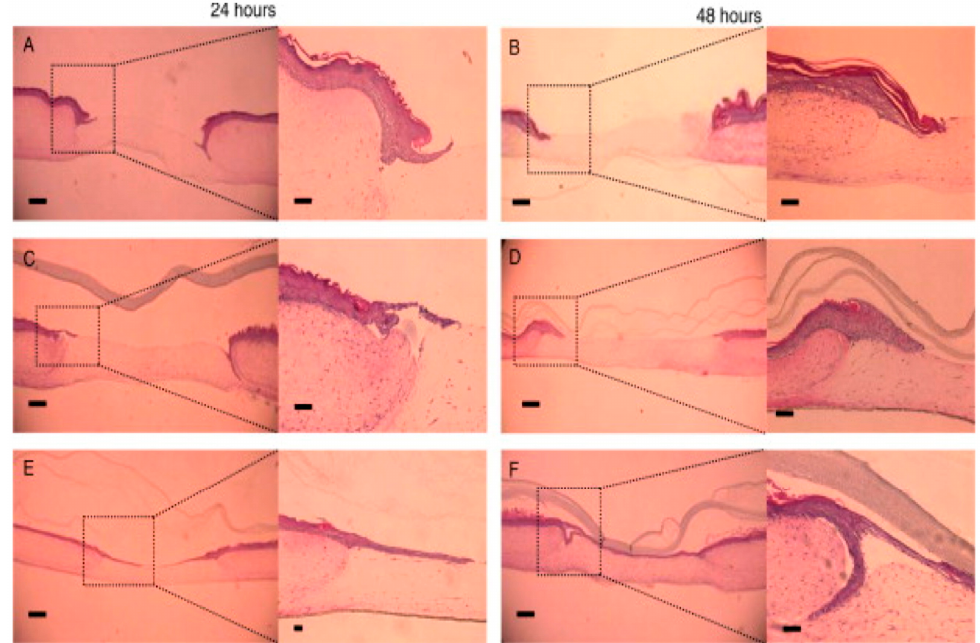
Figure 9. Hematoxylin and Enosin staining of wound after 24 and 48 h of treatment with silk nanofibers. ( A , B ) the control without silk dressing on the top of the wound, ( C , D ) samples of silk mat without EGF, ( E , F ) samples of silk mat consisting of EGF. It can be seen that silk mat with EGF shows complete closure of the wound after 48 h of incubation. Reproduced with permission from [261].